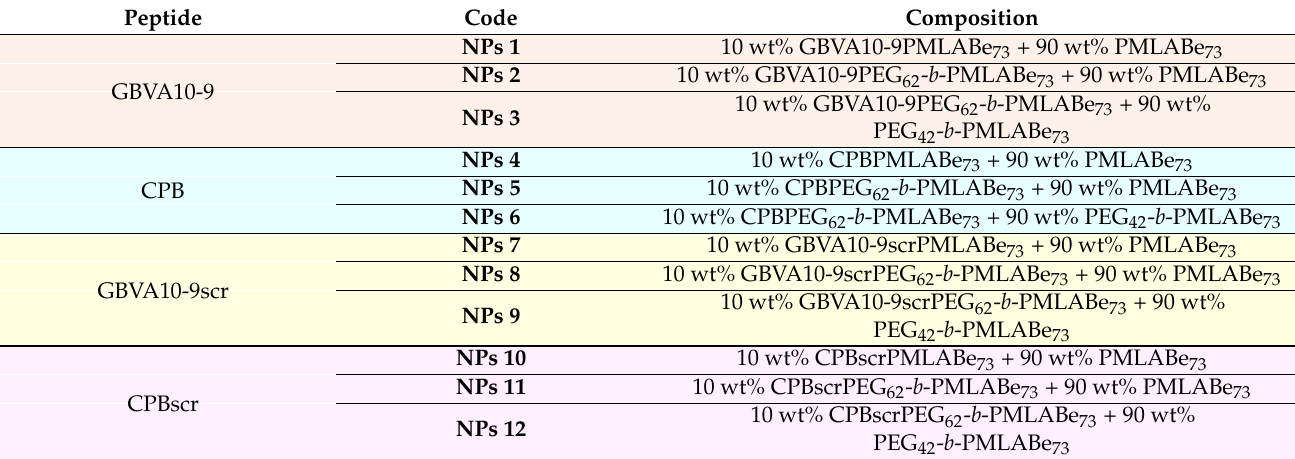
Table 1. Composition of peptide-decorated nanoparticles (Pept-NPs).